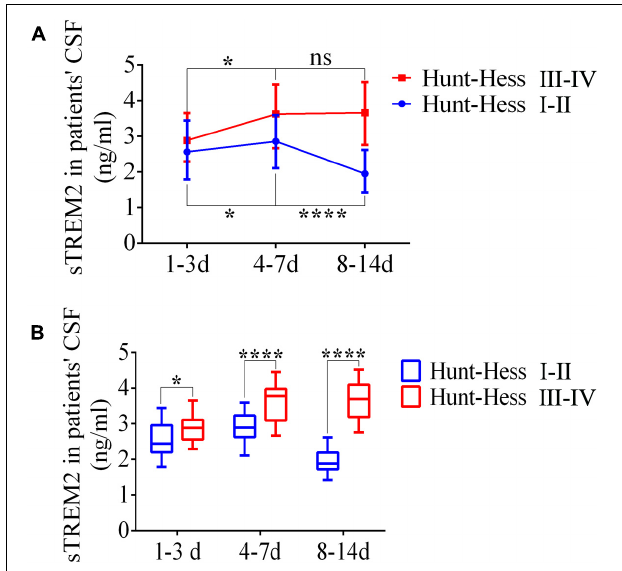
FIGURE 10 | Enhanced levels of soluble triggering receptor expressed on myeloid cells 2 ( TREM2 ) in the cerebrospinal fluid (CSF) of patients with subarachnoid hemorrhage (SAH). (A,B) ELISA-based analysis of s TREM2 in CSF samples of SAH patients with different Hunt–Hess grades. These data are shown as mean ± SEM ( ns p >0.05, * p <0.05, **** p